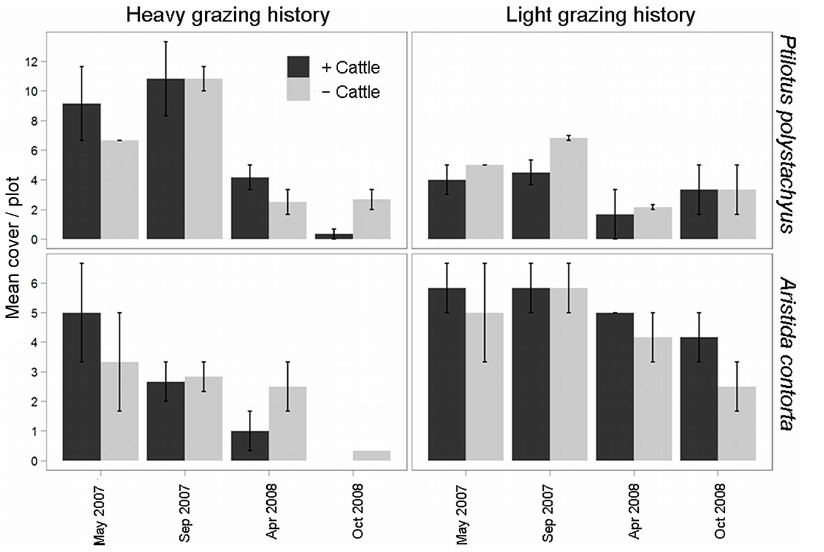
Figure 2. Percentage cover (mean ± SE) of the herb Ptilotuspolystachyus and the grass Aristidacontorta . Cover is averaged per plot, in sites with different historic grazing intensities (‘light’ and ‘heavy’) and recent cattle removal (‘ + cattle’ and ‘ 2 cattle’) in the Simpson Desert, central Australia, in May 2007, September 2007, April 2008 and October 2008. Prior to heavy rains in early 2007 there was no coverage of either P. polystachyus or A. contorta ; hence, data from these periods are not shown. doi:10.1371/journal.pone.0068466.g002 PLOS ONE |